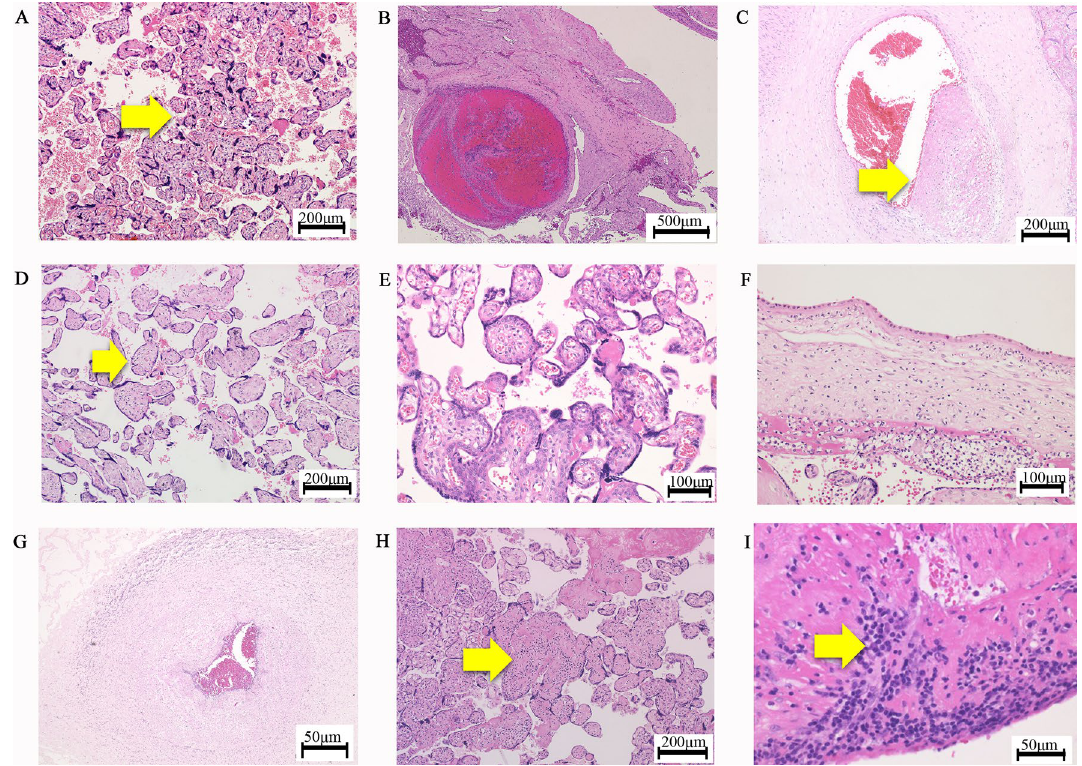
Figure 1. Representative pathological findings by HE staining of placentas. ( A ) ‘Accelerated villous maturation’; the yellow arrow indicates increases in the numbers of placental villi with the focal formation of tight adherent villous clusters with syncytial knots. ( B ) ‘Decidual arteriopathy’; A thrombus in decidual vessel. ( C ) ‘Thrombosis or Intramural fibrin deposition’; the yellow arrow indicates a fibrin cushion in the walls of stem villous vessels. ( D ) ‘Avascular villi’: the yellow arrow indicates a villus with hyalinized stroma, which is devoid of vessels. ( E ) ‘Delayed villous maturation’. ( F ) ‘Maternal inflammatory response’; the infiltration of neutrophils into the chorionic plate. ( G ) ‘Fetal inflammatory response’; the infiltration of neutrophils into the umbilical artery. ( H ) ‘VUE; villitis of unknown etiology’; the yellow arrow indicates lymphohistiocytic inflammation predominantly in the stroma of terminal villi. ( I ) ‘Deciduitis’; the yellow arrow indicates the infiltration of plasma